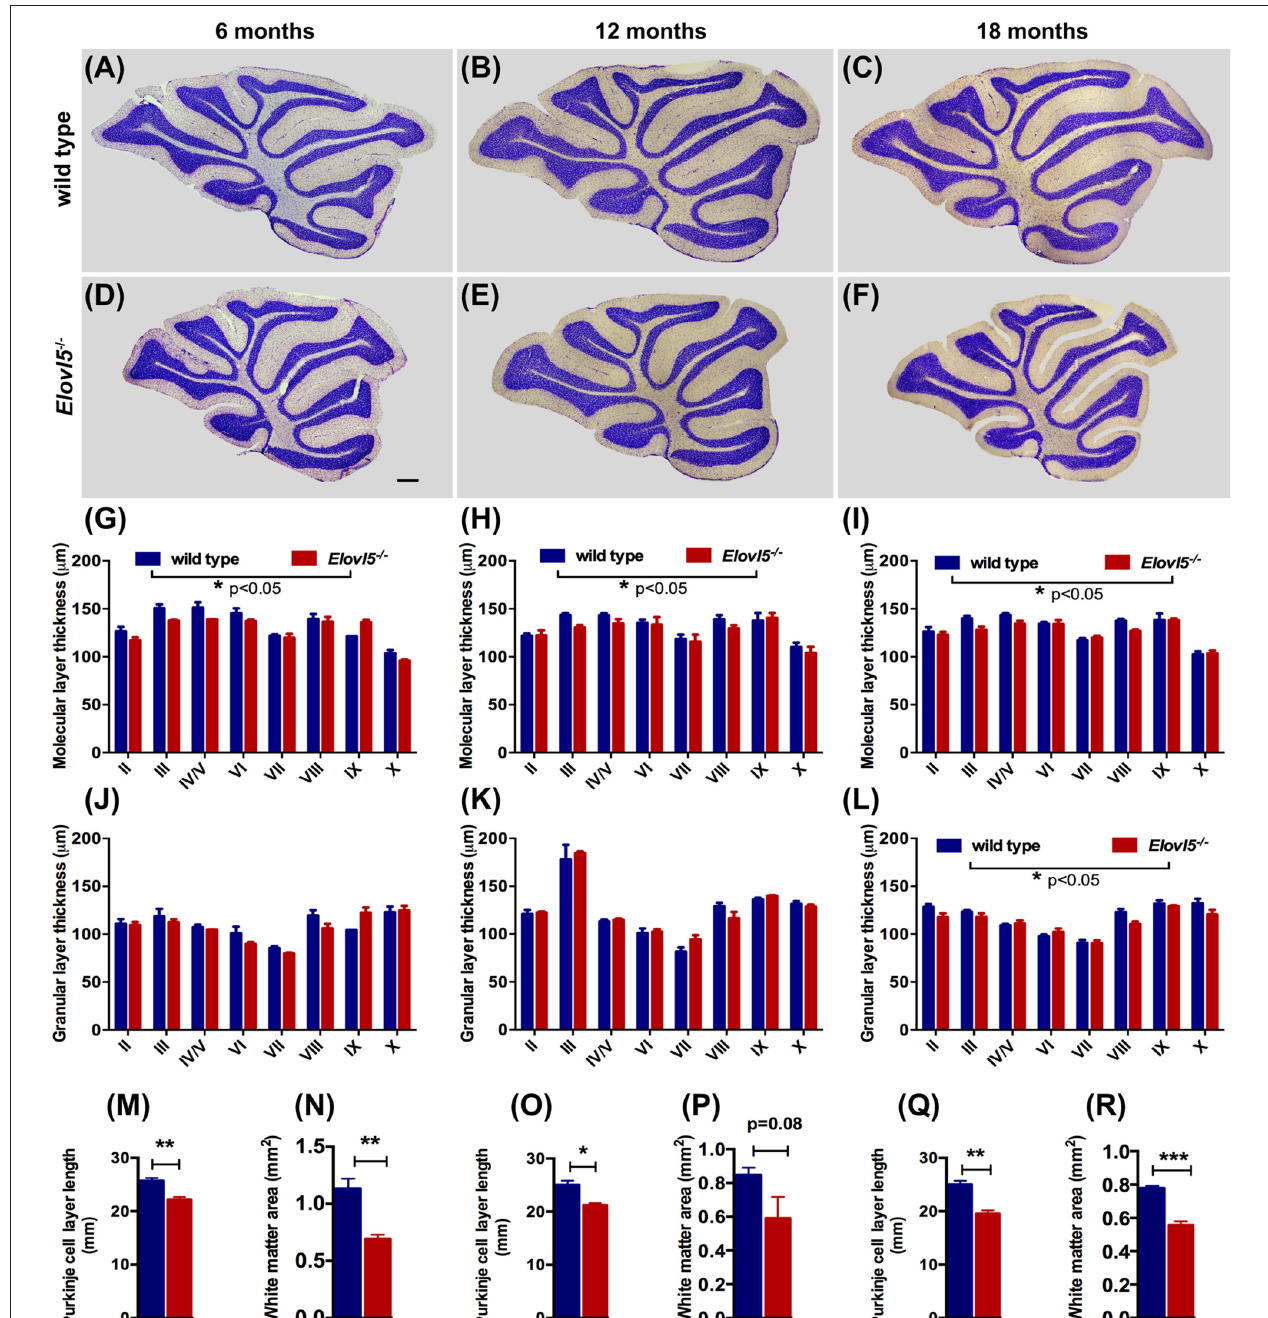
FIGURE 4 | Elovl5 − / − mice show cerebellar atrophy. (A–F) Nissl-stained sagittal sections of the cerebellum from wild type (A–C) and Elovl5 − / − mice (D–F) at 6, 12 and 18 months of age. (G–I) Average thickness of the molecular layer and (J–L) granular layer of each cerebellar lobule for Elovl5 − / − (red) and wild type mice (blue) at 6, 12 and 18 months, respectively. (M,O,Q) Reduced total perimeter length of the PC layer and (N,P,R) white matter area in the cerebellum of Elovl5 − / − mice at all ages analyzed. ∗ p < 0.05; ∗∗ p < 0.01, ∗∗∗ p < 0.001 two way ANOVA. Results are reported as mean ± SEM. Scale bar 100 µ m.